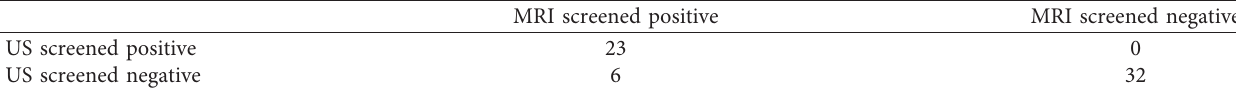
Table 2: Summary of results of the 61 patients prescreened for temporomandibular symptoms using ultrasound (US) and compared to the gold standard of magnetic resonance imaging (MRI). US results are split into true positive and true negative (concordant with MRI), and false positive and false negative (discordant with MRI), corresponding to a sensitivity of 79% and specificity of 100%.